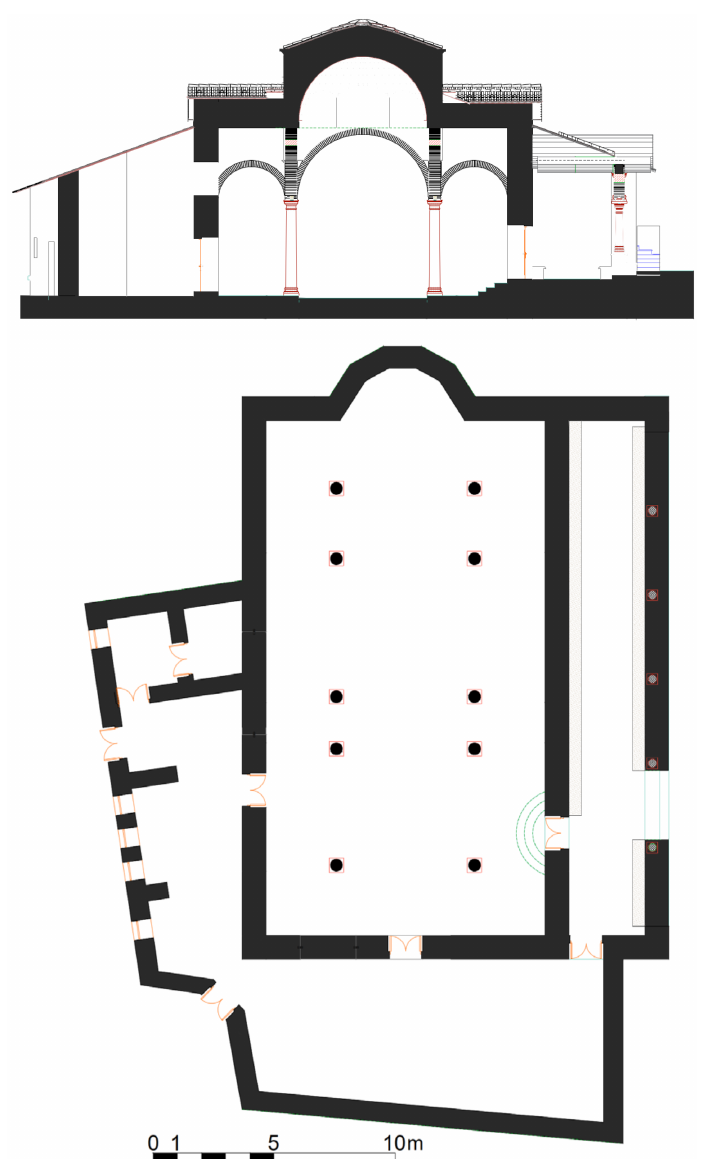
Figure 2. Plan layout and transversal section of St Mary Assumption’s church. Provision courtesy of Arch. Arsim Murseli, UBT University, Pristina, Kosovo.